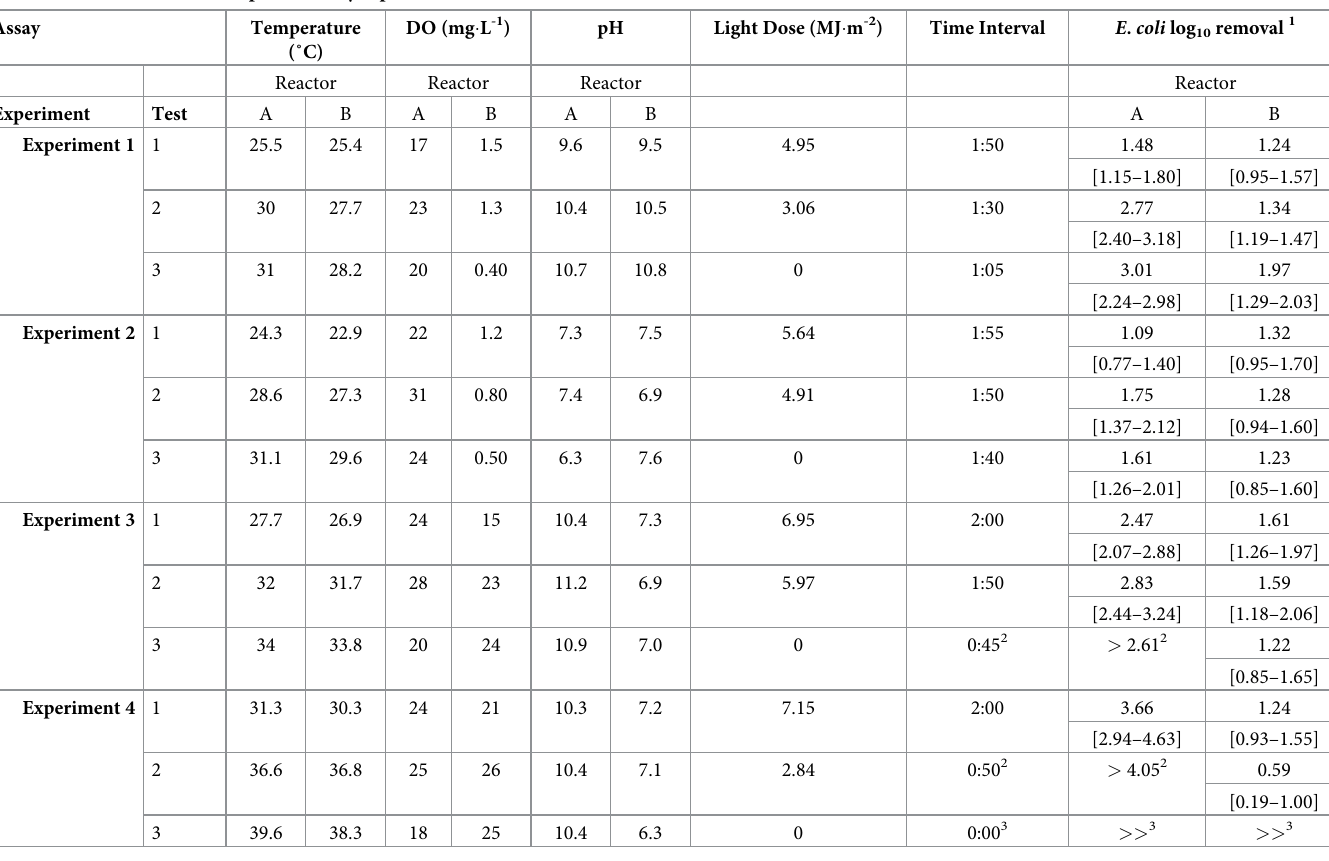
Table 2. Results from bench experiments by experiment.